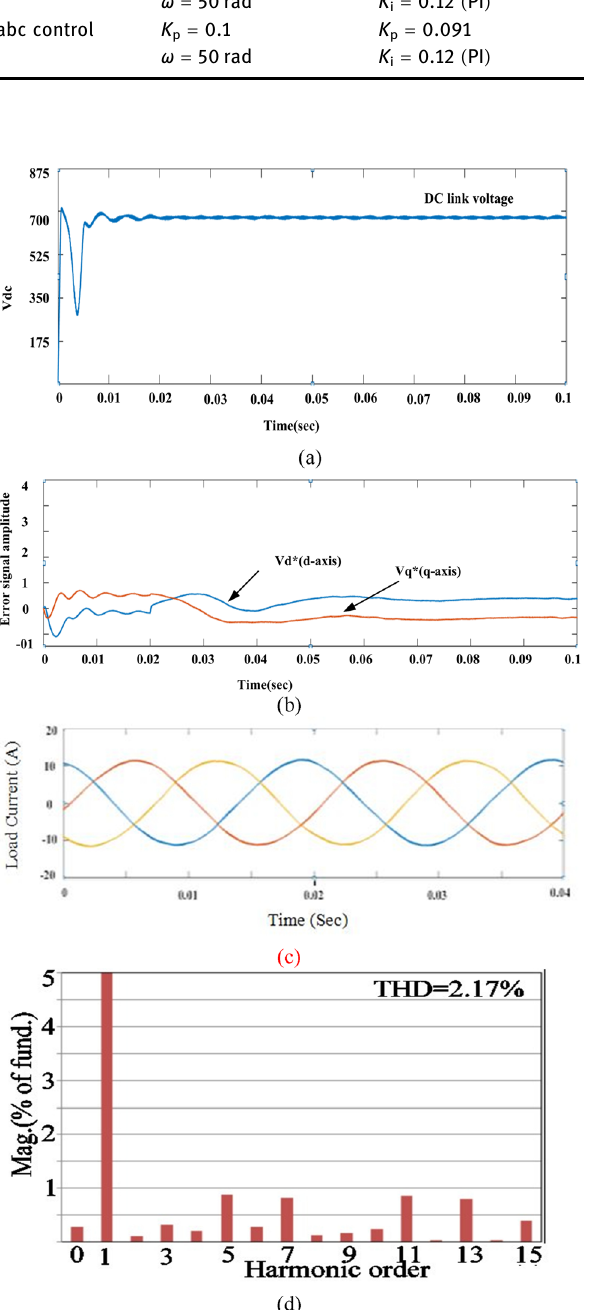
Figure 8: Results for stationary reference frame: ( a ) DC - link voltage, ( b ) error signal, ( c ) inverter output current, and ( d ) THD of output